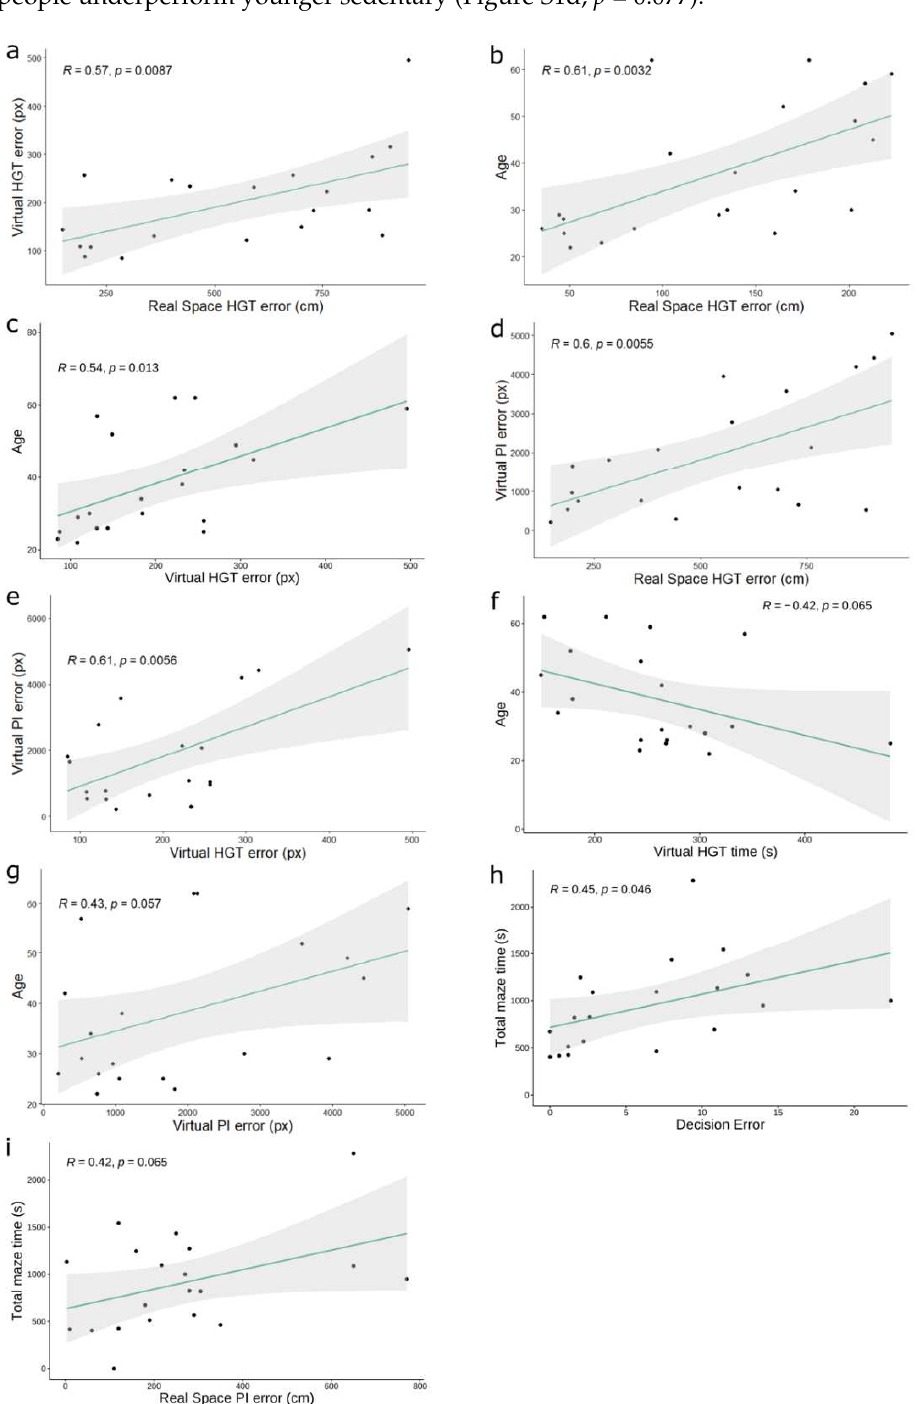
Figure 5. Significance of the main correlations between measurements. ( a – h ) Correlations of validated tests with each other or with subjects’ age. Significant positive correlations ( a – e ) can be seen, as well as a trend in the performance of virtual versions of hidden goal test and path integration with age ( f , g ). A significant correlation was found between the decision error of our new multiple-choice real-space maze and the time spent in the maze (internal validation, h ), and a trend between the time spent in the maze with the error in the path integration test (inter-test validation, ( i )). Each dot represents 1